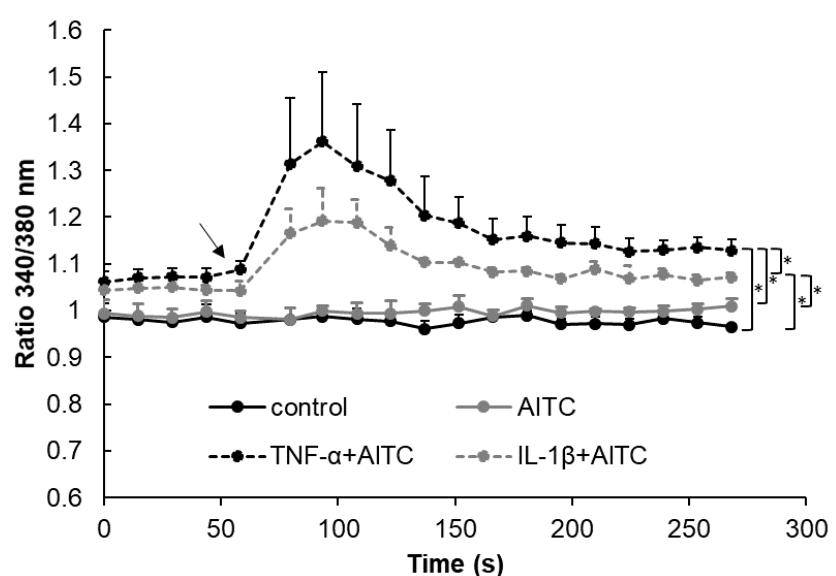
Figure 3. Calcium flux in IVD cells untreated (control) and treated with 100 µM Allyl isothiocyanate (AITC) with and without 10 ng/mL IL-1 β or 10 ng/mL TNF- α . Graph shows calcium flux as 340/380 signal ratio (mean ± SD, n = 3). Asterisks indicate statistical significance (* p < 0.05, Kruskal–Wallis test and Dunn’s multiple comparison test). The arrow indicates AITC application.